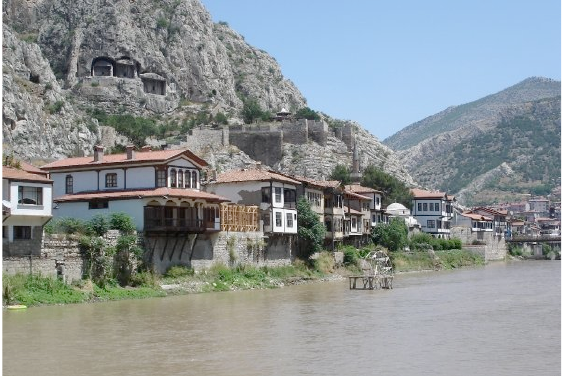
Figure 2. Hatuniye District